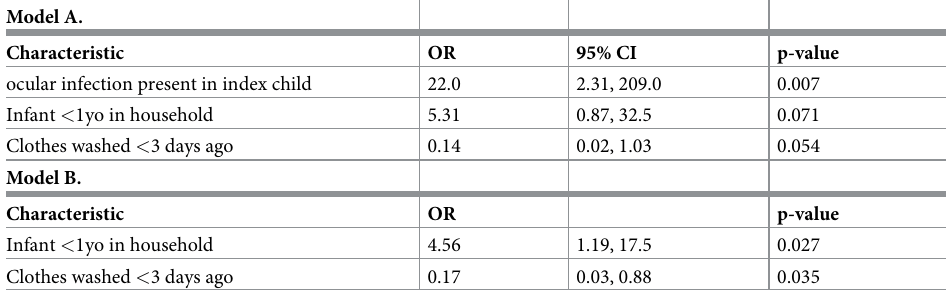
Table 5. Adjusted associations between positive environment swabs and household characteristics and reported behaviors. Model